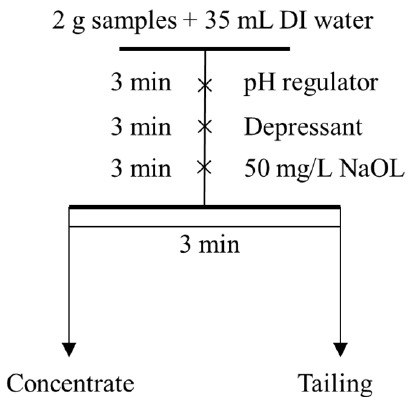
Figure 4. Flowsheet of the single mineral flotation test.